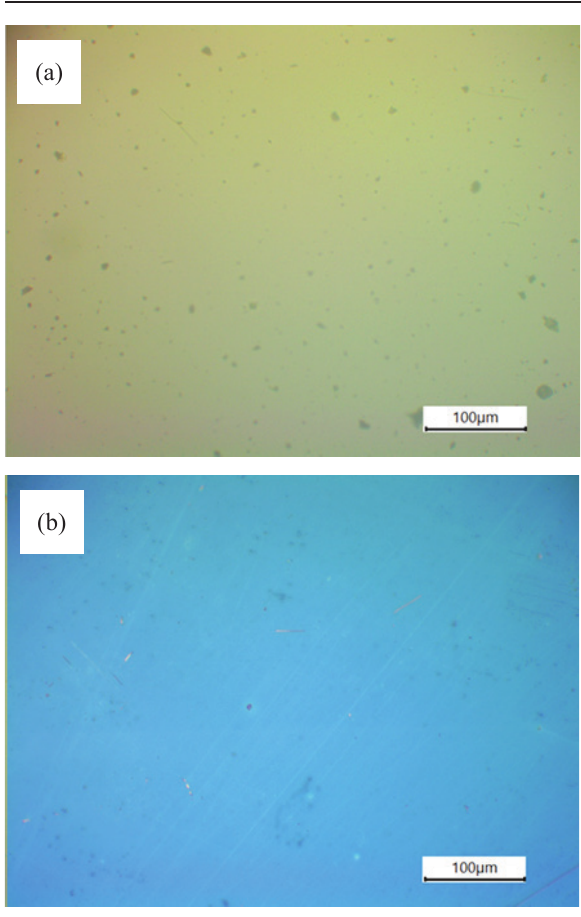
Fig. 2 – Images of optical microscopy with magnification of 100x of silicon (a) and TiO deposited by sol-gel (b) 2